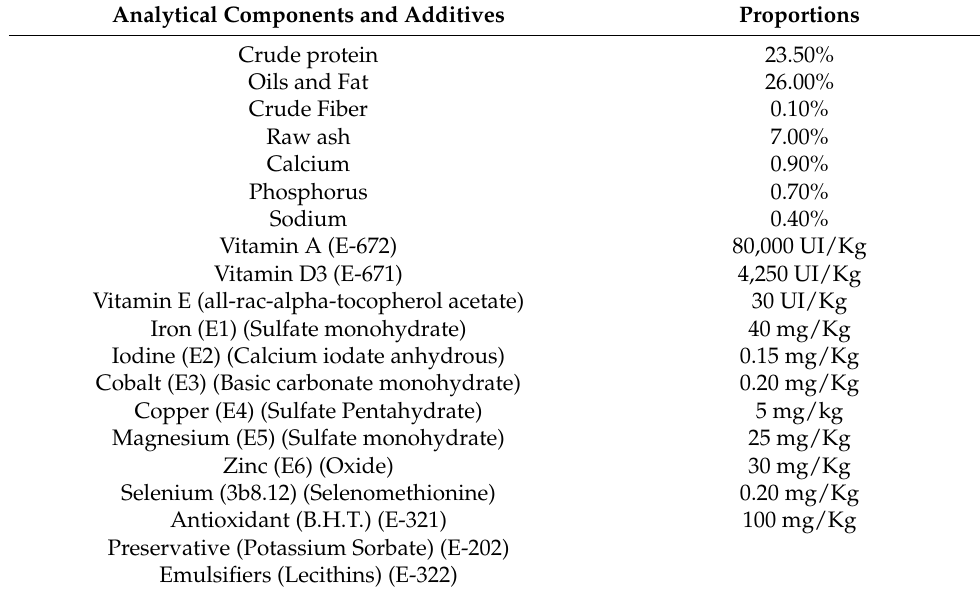
Emulsifiers (Lecithins)